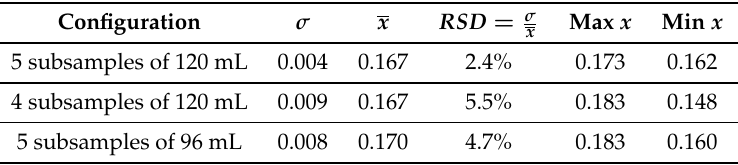
Table 1. Configuration comparison VFA/TIC parameters.